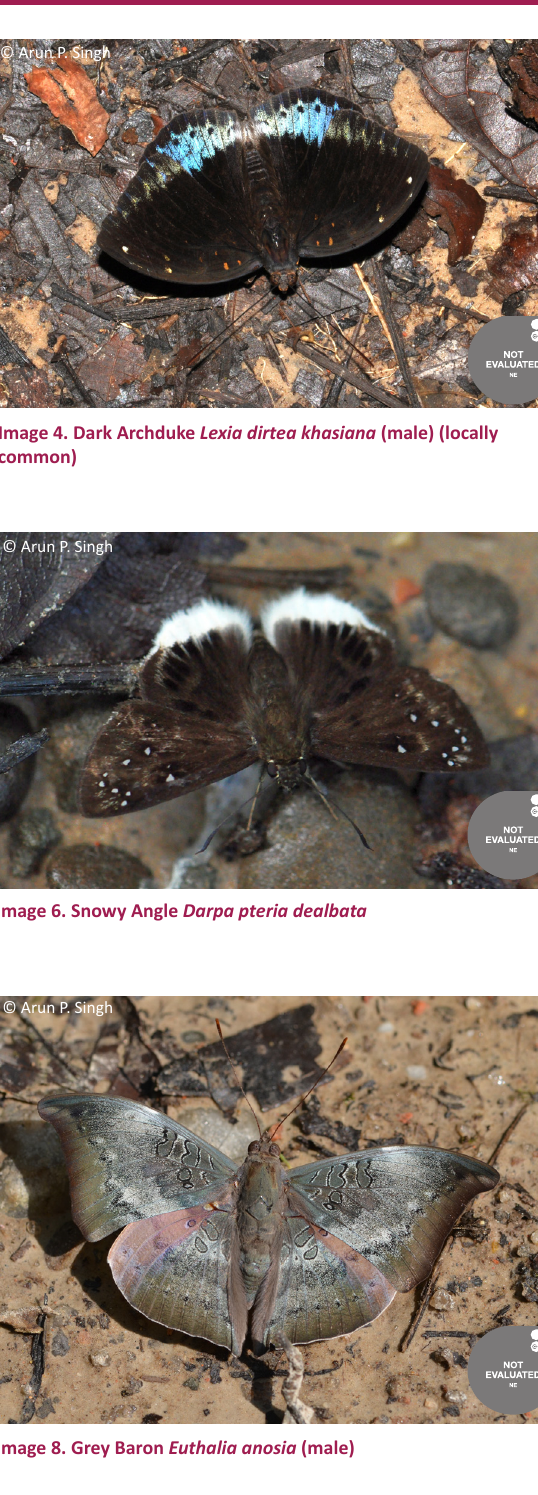
2014. Branded Yamfly Yasoda tripunctata tripunctata (Image 12) is yet another rare species , which is also distributed from Sikkim to Myanmar, was recorded once on 25 October 2011